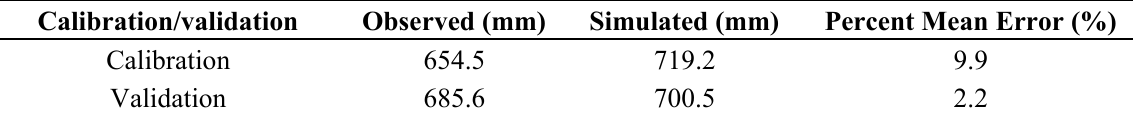
Table 4. Annual mean values and percent mean error for calibration and validation.